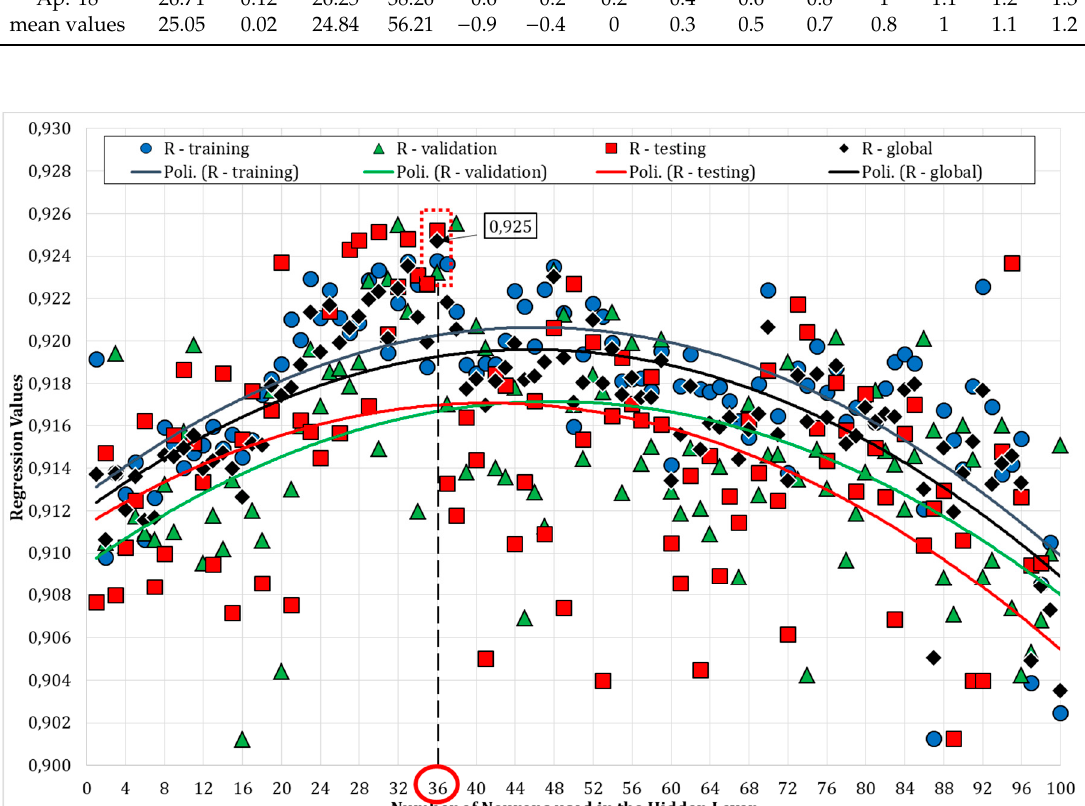
Figure 4. Neural Network Implementation: sensitivity analysis results (R = regression value for each development process: training, validation, testing and global).